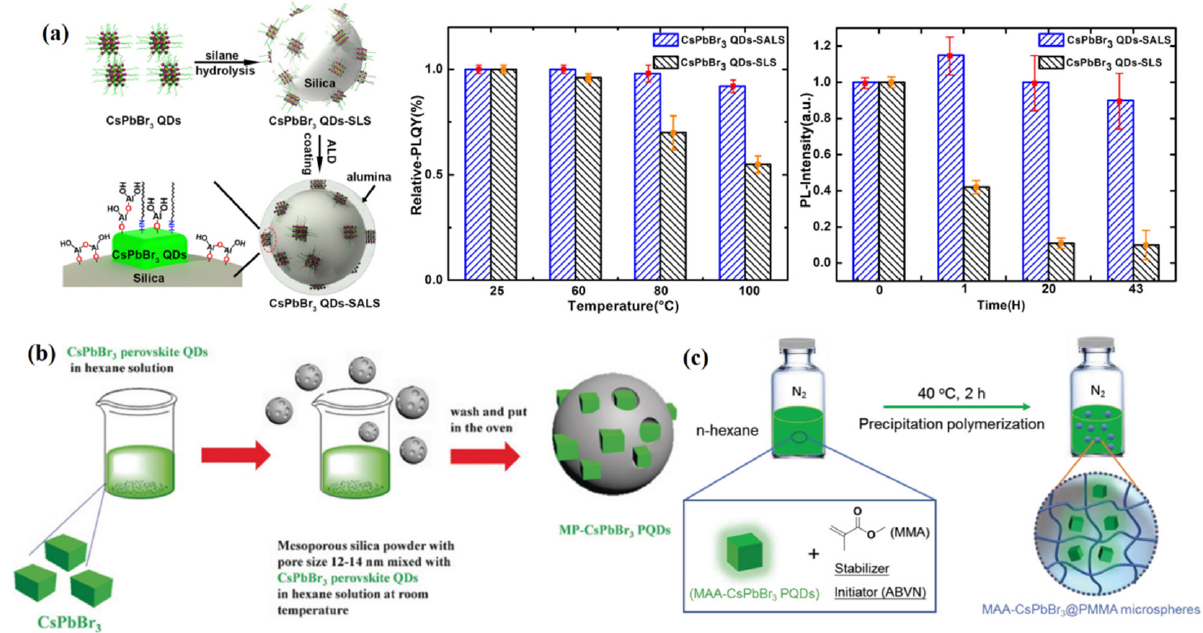
Figure 7. ( a ) Schematic diagram of selective surface passivation of CsPbBr 3 QDs silicon luminescent sphere (SALS) by ALD (left); thermal stability, and photostability of as-prepared CsPbBr 3 QDs-SLS and QDs-SALS (right). Adapted with permission from [95]. Copyright 2018, American Chemical Society. ( b ) The synthesis process of mesoporous silica green PQDs nanocomposite (MP-PQDs). Reproduced with permission from [96]. Copyright 2016, Wiley. ( c ) Illustration of the preparation process of MAA-CsPbBr 3 @PMMA microspheres. Reproduced with permission from [103]. Copyright 2019, Wiley.